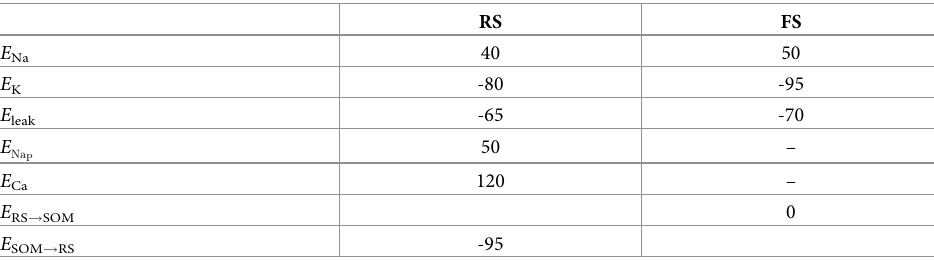
Table 4. For numerical stability, the backwards and forwards rate constants for q and s were Table 2. Equilibrium